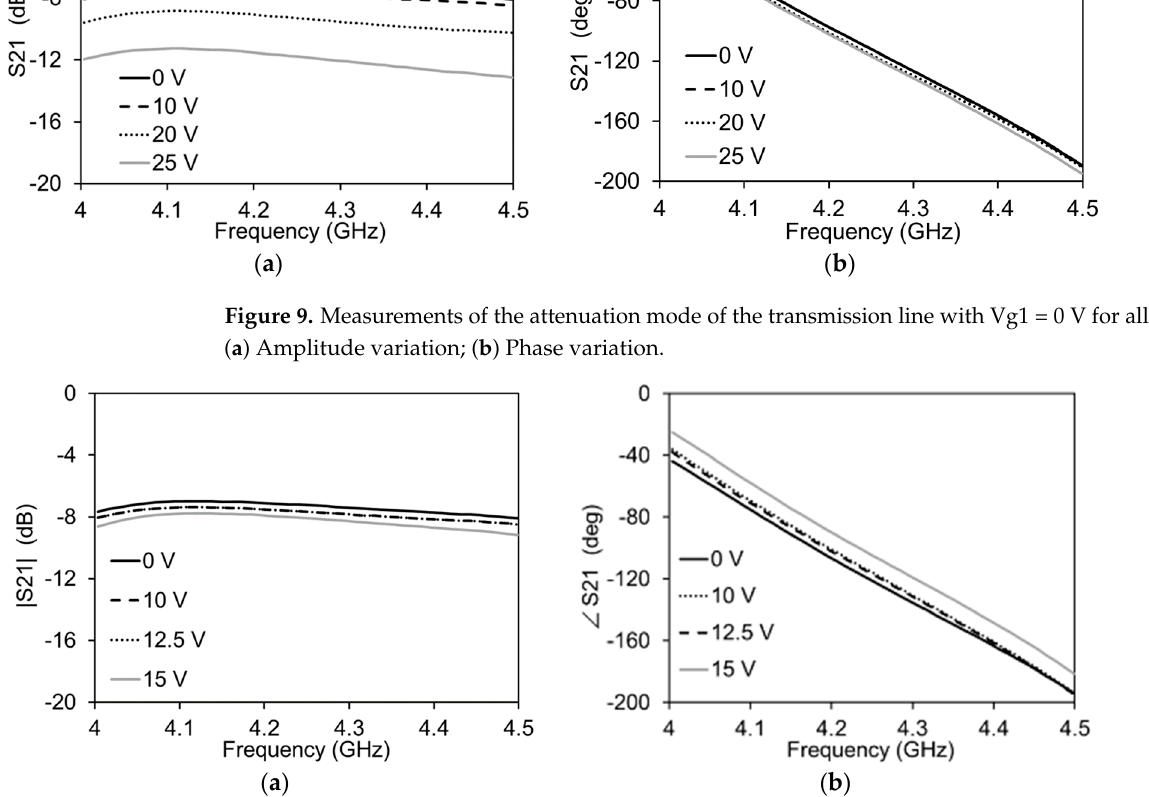
Figure 10. Measurements of the phase shifter mode of the transmission line with Vg = 0 V for all